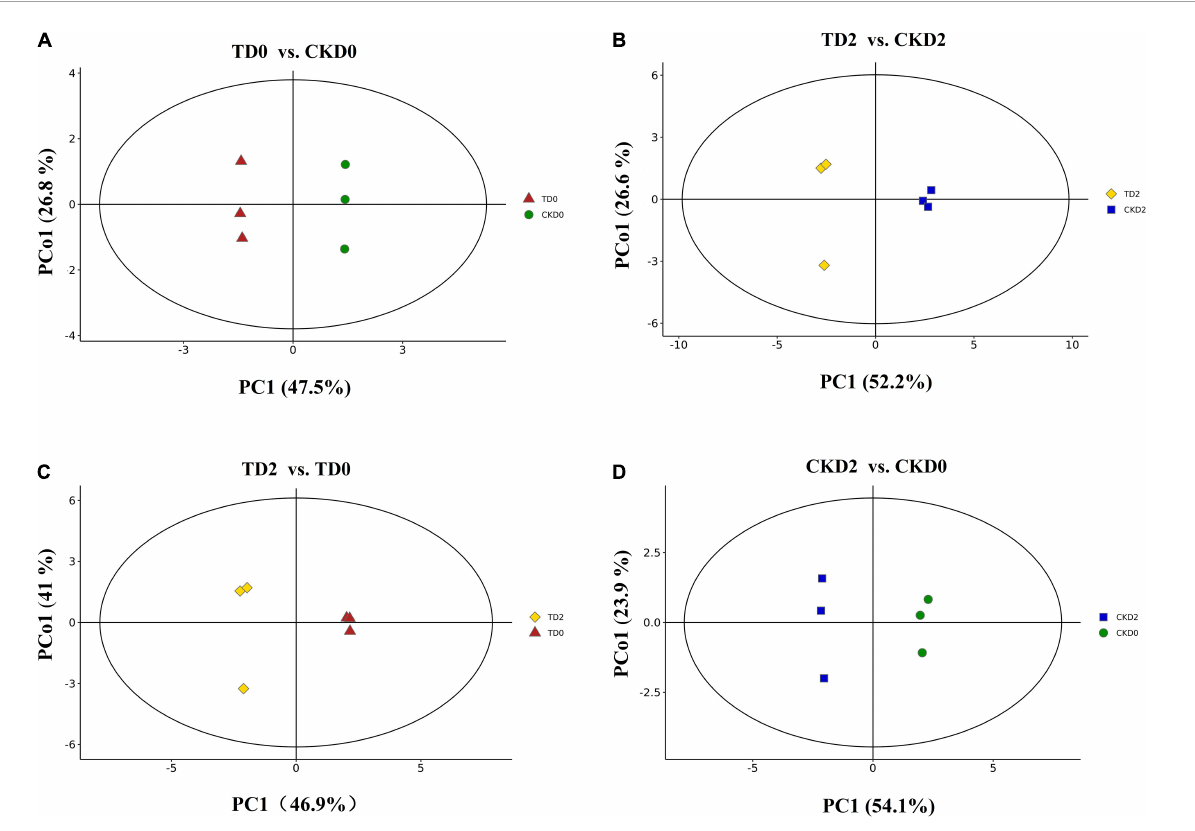
FIGURE4 OPLS–DA model plots for the comparison groups, including TD0 vs. CKD0, TD2 vs. CKD2, TD2 vs. TD0, and CKD2 vs. CKD0 (A–D) .